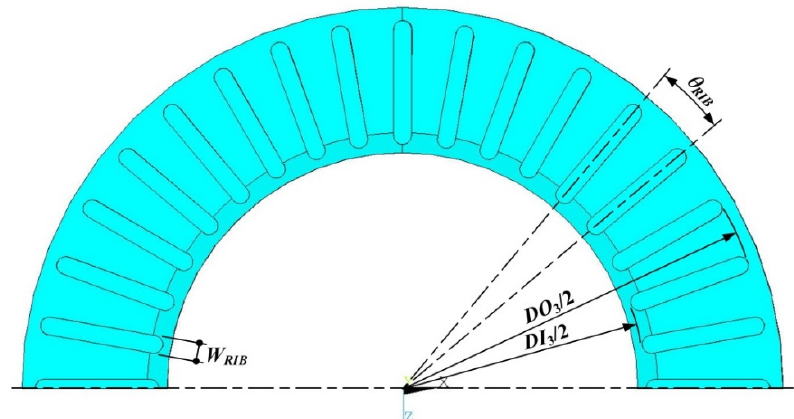
Figure 6. Geometrical parameters defining the ribs of the rotor. Table 1. Initial values of the 22 geometrical parameters for the baseline model. §